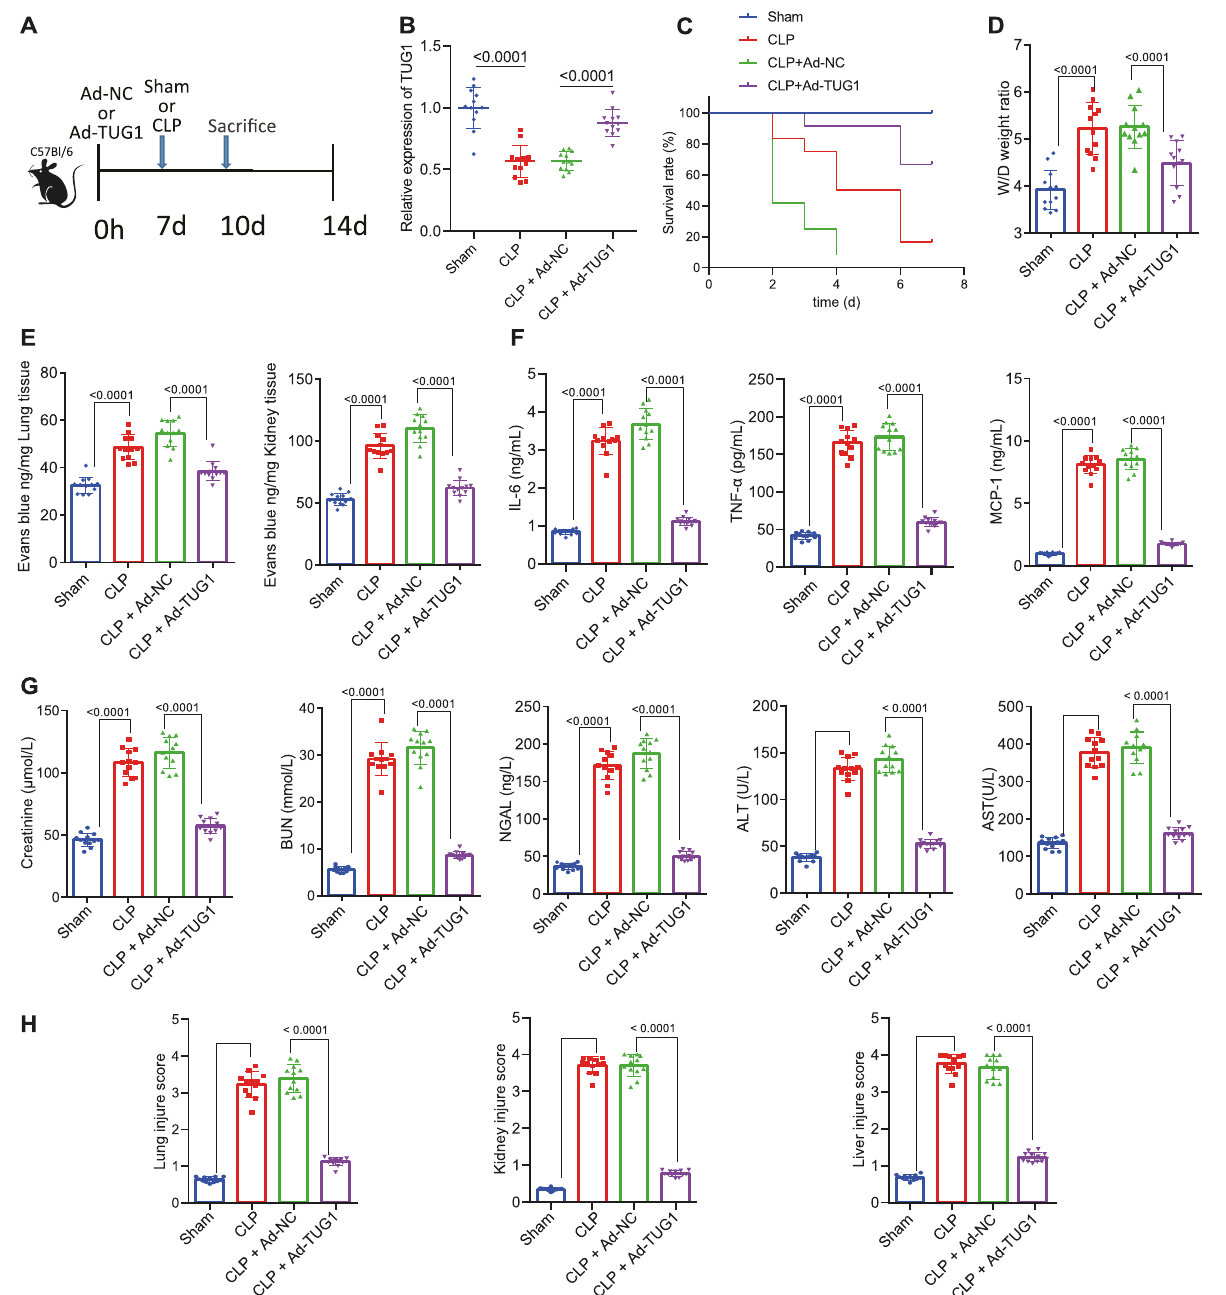
Fig. 1 Upregulated TUG1 suppresses in fl ammation in the pulmonary vascular endothelial cells and alleviates sepsis in mice. A Flow chart of septic mice treated with Ad- TUG1 vector. B The expression of TUG1 in the lung tissues of septic mice determined by RT-qPCR. C The survival rate of mice within 7 days after treatment. D Pulmonary edema in septic mice assessed by the wet/dry ratio. E The measurement of blood vessel leakage in lung and liver of septic mice using Evans blue dye. F Serum levels of IL-6, TNF- α , and MCP-1 were determined by ELISA. G Determination of creatinine, BUN, NGAL, AST, and ALT levels in mouse serum. H The quantitative analysis of tissue damage scores in lung, liver, and kidney tissues. Measurement data were expressed as mean ± standard deviation. One-way ANOVA was adopted for comparison between multiple groups followed by Tukey ’ s post hoc test. Kaplan – Meier analyses were performed to calculate the survival rate. Log-rank test was conducted for univariate survival analysis. * p < 0.05 vs. sham-operated mice; # p < 0.05 vs. CLP-operated mice treated with Ad-NC ( n = 12).